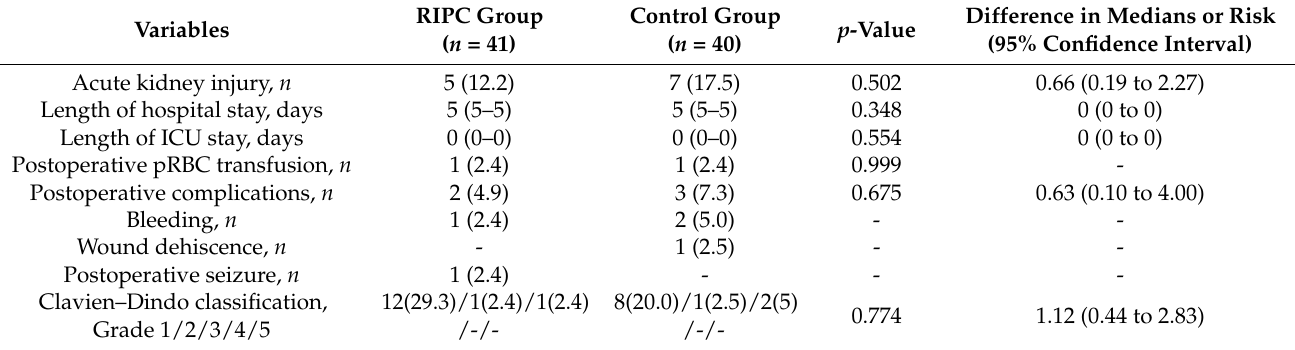
Figure 3. Comparison of the time-dependent changes in the estimated glomerular filtration rate between the RIPC and control groups. The time points were defined as preoperative (T1), at post-anesthesia care unit (T2), postoperative day 1 (T3), postoperative day 3 (T4), and two weeks after surgery (T5). Table 3. Comparison of the secondary clinical outcomes between the RIPC and control